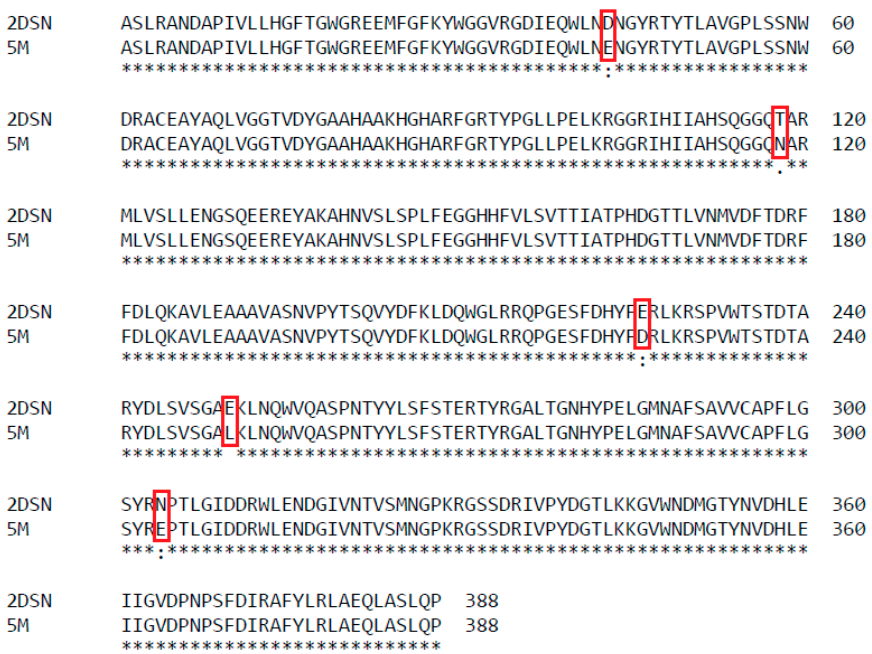
Figure 1. Alignment of 5M mutant with T1 lipase for verification of mutation at amino acid position 43, 118, 226, 250, and 304. The mutated residues are marked in red box.